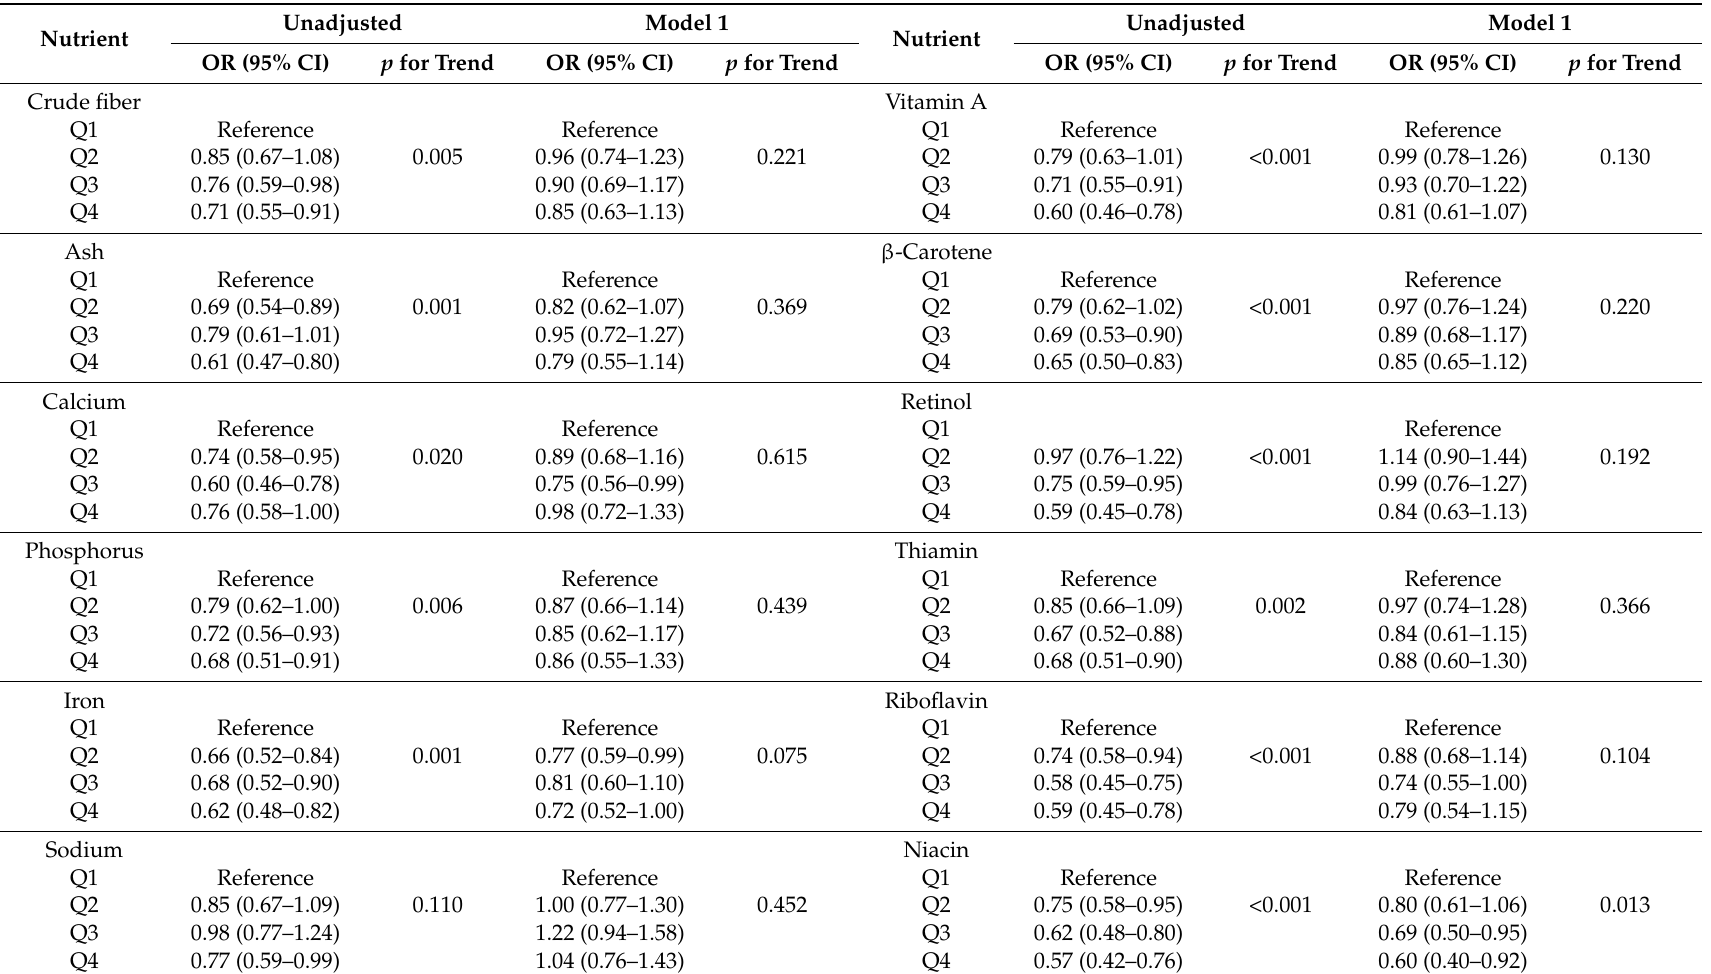
Table 4. Odds ratios of nutritional factors for